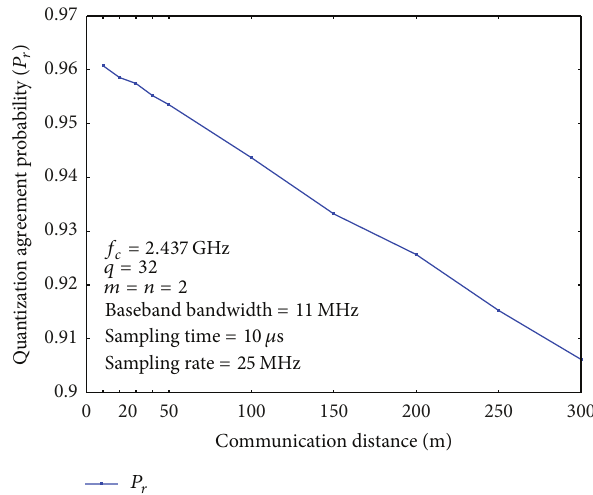
Figure 5: Average SNRs under different communication distances.